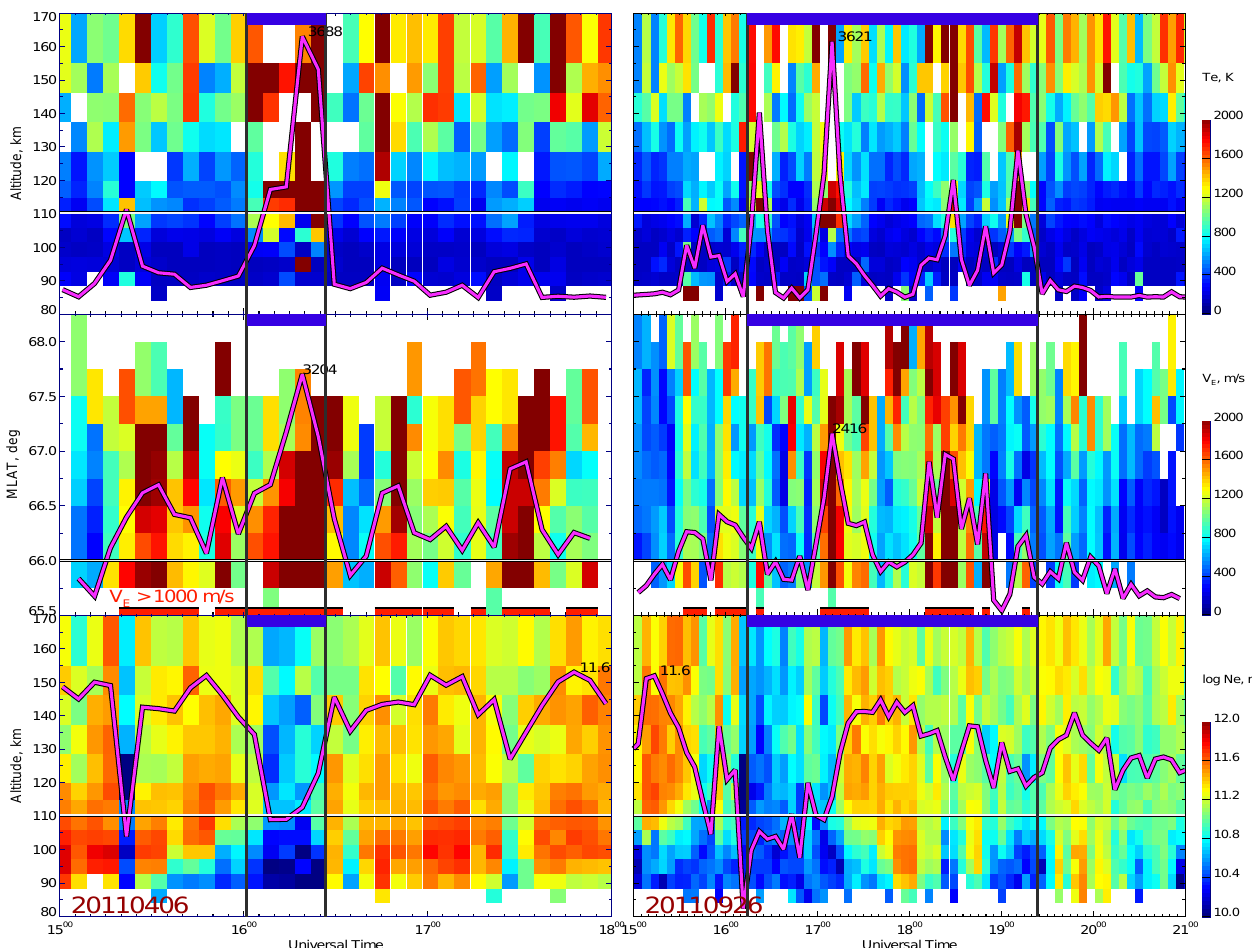
Fig. 3. Examples of anomalous electron heating (AEH) events. The three rows represent (from top to bottom): AC electron temperatures in the field-aligned beam 64157 versus UT and altitude, LP ion velocity for various MLAT bins, and AC electron density in beam 64157. The colour bars are shown to the right of each row. The black-white line shows an altitude of ∼ 110km for the T e and N e datasets and a MLAT of 66.0 ◦ for the V E dataset. The pink line shows time variation of the corresponding parameter at the bin shown by the black-white line in arbitrary scale. The maximum parameter value is shown by the digits near the peak. The dark red horizontal lines at the bottom of the middle row show intervals with V E > 1000ms − 1 . Black vertical lines and colour stripes show the AEH